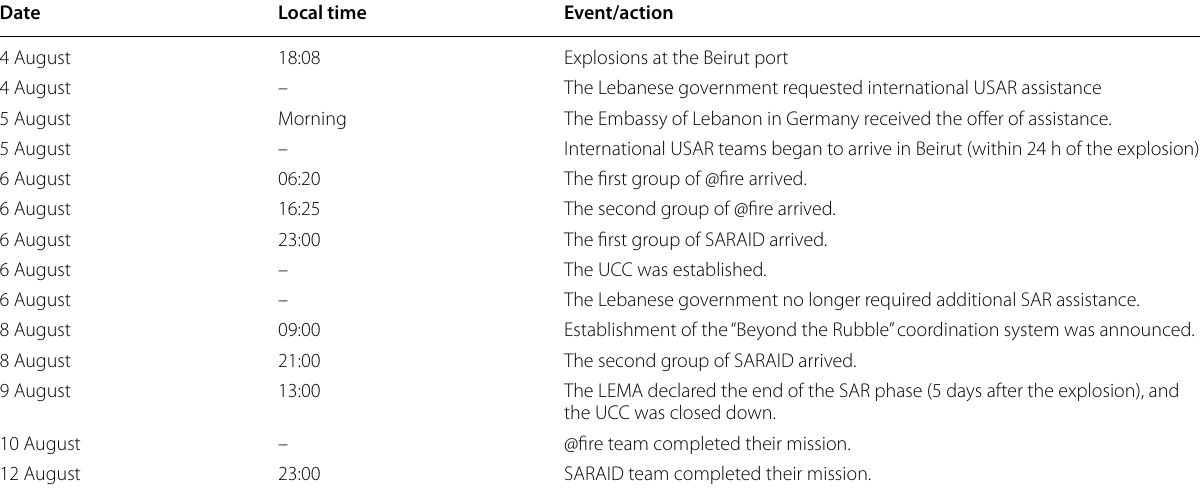
Table 3 Chronology in the Beirut response with a focus on international USAR response (e.g. @fire,